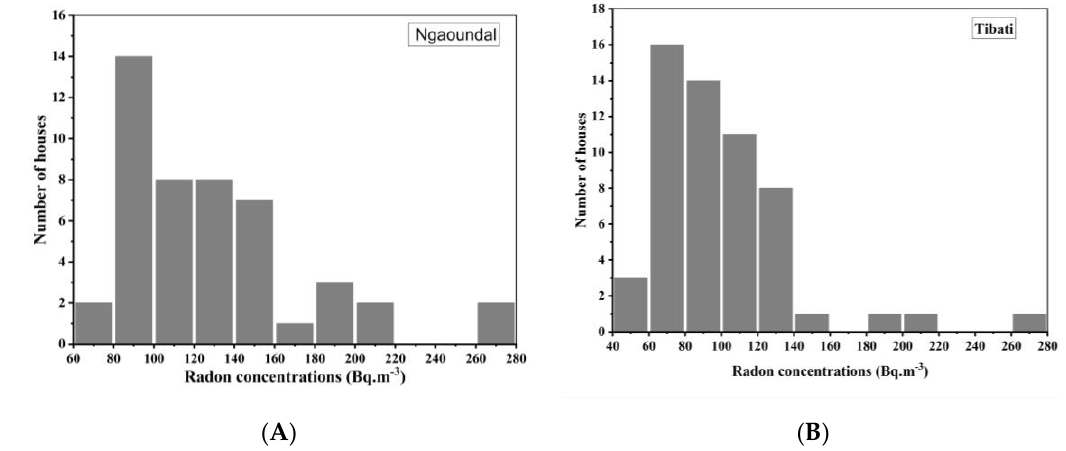
Figure 3. Lognormal distribution of 222 Rn in houses of Ngaoundal ( A ) and Tibati ( B ) using RADTRAK detectors. The numbers of houses are 48 and 56 in Ngaoundal and Tibati, respectively.